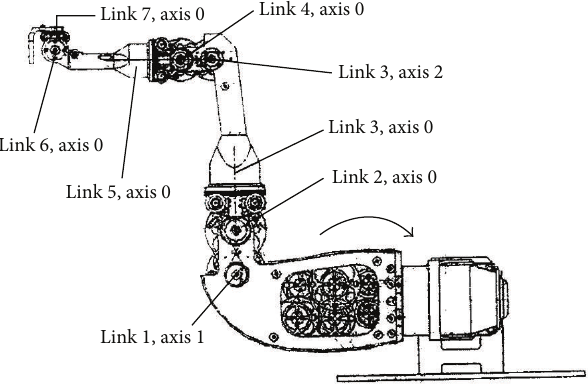
Figure 2: DEXTER robotic arm: axis, joints, and links